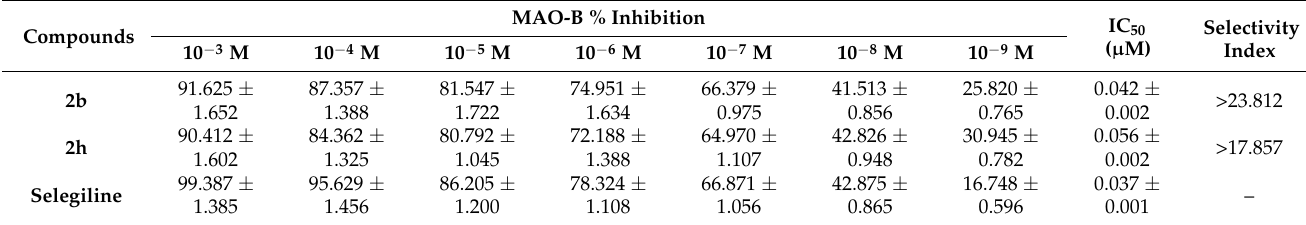
Table 2. IC 50 values of compounds 2b , 2h , and Selegiline against MAO-B.